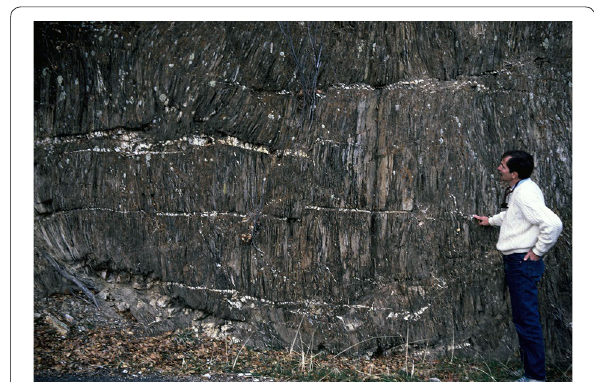
Fig. 2 Swarm of predominantly subhorizontal quartz-infilled extension veins disrupting Calaveras slates, near Carson Hill, Mother Lode belt, CA (David P. Hill for